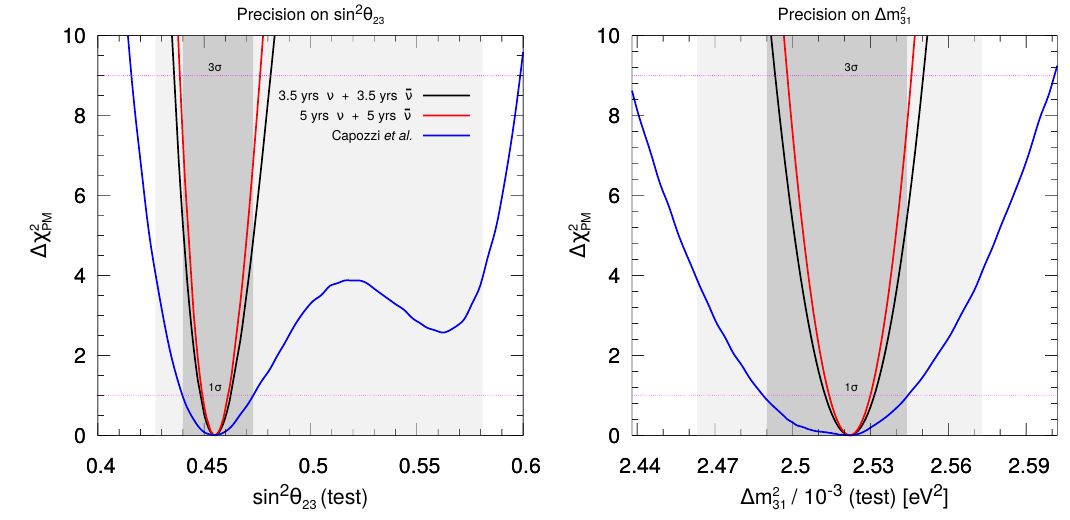
around sin 2 θ (true) = 0 . 455 and the right panel depicts Figure 12 . The left panel shows ∆ χ 2 23 PM (true) = 2 . 522 × 10 − 3 eV 2 assuming true NMO and δ ∆ χ 2 for ∆ m 2 (true) = 223 ◦ . The black CP 31 PM (red) curves show the precision with 7 (10) years of exposure, equally divided in neutrino and antineutrino modes. Blue lines portray the present precision from the global fit study [11]. In the fit, we marginalize over the current 3 σ range of ∆ m 2 (sin 2 θ ) in the left (right) panel. In both the 23 31 panels, we also marginalize over the current 3 σ range of δ , while keeping rest of the oscillation CP parameters fixed at their present best-fit values as shown in table 1. The dark (light)-shaded grey area shows the currently allowed 1 σ (2 σ ) region in sin 2 θ ( ∆ m 2 ) in the left (right) panel as 23 31 obtained in the global fit study [11] assuming NMO. The precision at 1 σ ( ∆ χ 2 = 1 ) and 3 σ PM ( ∆ χ 2 = 9 ) confidence levels are shown by horizontal pink dotted PM